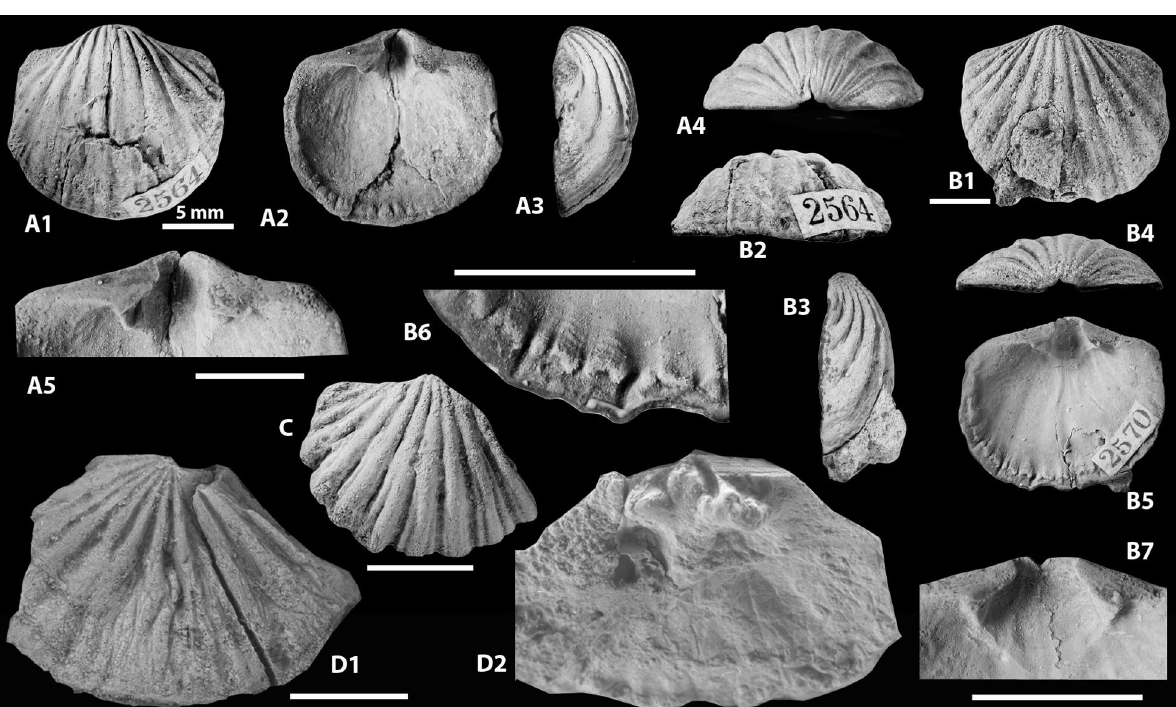
Fig. 3. Rogorthis pakriensis (Rubel, 1961), middle part of the Kunda Stage, Pakri Formation (lowermost Darriwilian). A1 (cid:150) A5 , ventral valve GIT 125-98 (old number Br 2564), (Rubel 1961, p. 181); exterior, interior, lateral, posterior and anterior views; A5, view of the interarea and teeth. Northwestern Estonia, Island of V(cid:228)ike-Pakri. B1 (cid:150) B7 , ventral valve, holotype, GIT 125-102 (Br 2570), (Rubel 1961, pl. 17, fig. 4), northwestern Estonia, Island of V(cid:228)ike-Pakri. B1(cid:150)B5, ventral, interior, lateral and posterior views, and view of the posterior part of the ventral interior; B6, view of the ribbing along the interior margin; B7, view of the posterior part of the interior. C , exterior view of ventral valve GIT 125-103 (Br 2571), (Rubel 1961, pl. 18, fig. 1). Locality unknown. D1, D2 , exterior and interior of incomplete dorsal valve GIT 125-104 (Br 2572), (Rubel 1961, pl. 18, figs 2, 3). Northern Estonia, J(cid:228)gala. Scale bars correspond to 5